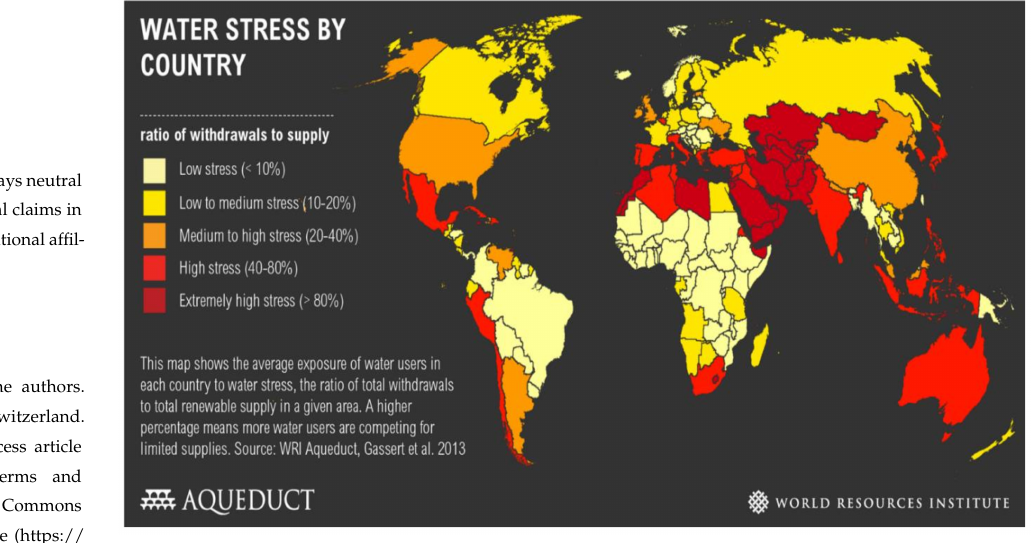
Figure 1. Global overview of water shortage